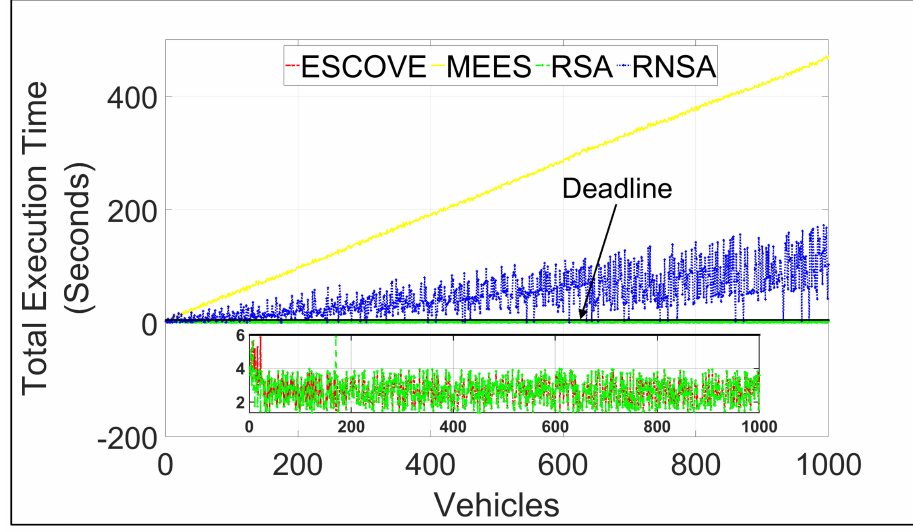
Figure 11. Total execution times of requests using ESCOVE, MEES, RSA, and